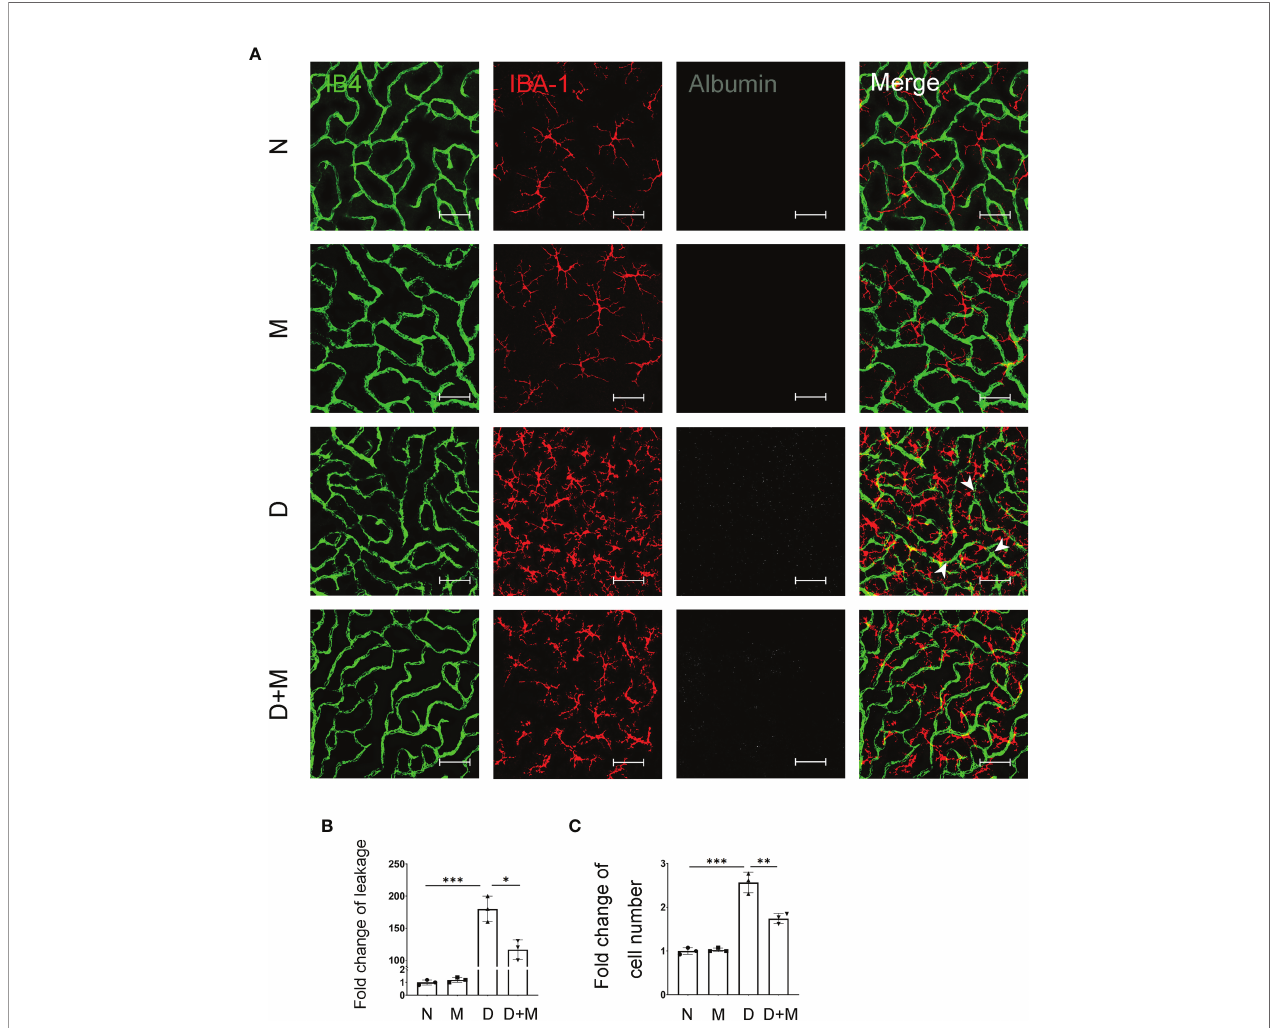
FIGURE 3 | Melatonin alleviates diabetes-induced retinal vascular leakage and endothelial cell damage. (A) Representative images of IB4 (green), IBA-1 (red), and albumin (white) immunolabeling in deep capillary plexus of the retinal fl atmounts in normal control and diabetic rat retinas with or without melatonin treatment. Leaked albumin is indicated by white arrowheads. (B) Quanti fi cation of albumin leakage in the retinas. (C) Quanti fi cation of microglial number in normal control and diabetic rat retinas with or without melatonin treatment. Data are expressed as mean ± SEM (n = 3 retinas per group). N, normal control group; M, melatonin treatment group; D, diabetes group; D+M, diabetes with melatonin treatment group; *p < 0.05, **p < 0.01, ***p < 0.001 by one-way ANOVA. Scale bar, 50 m